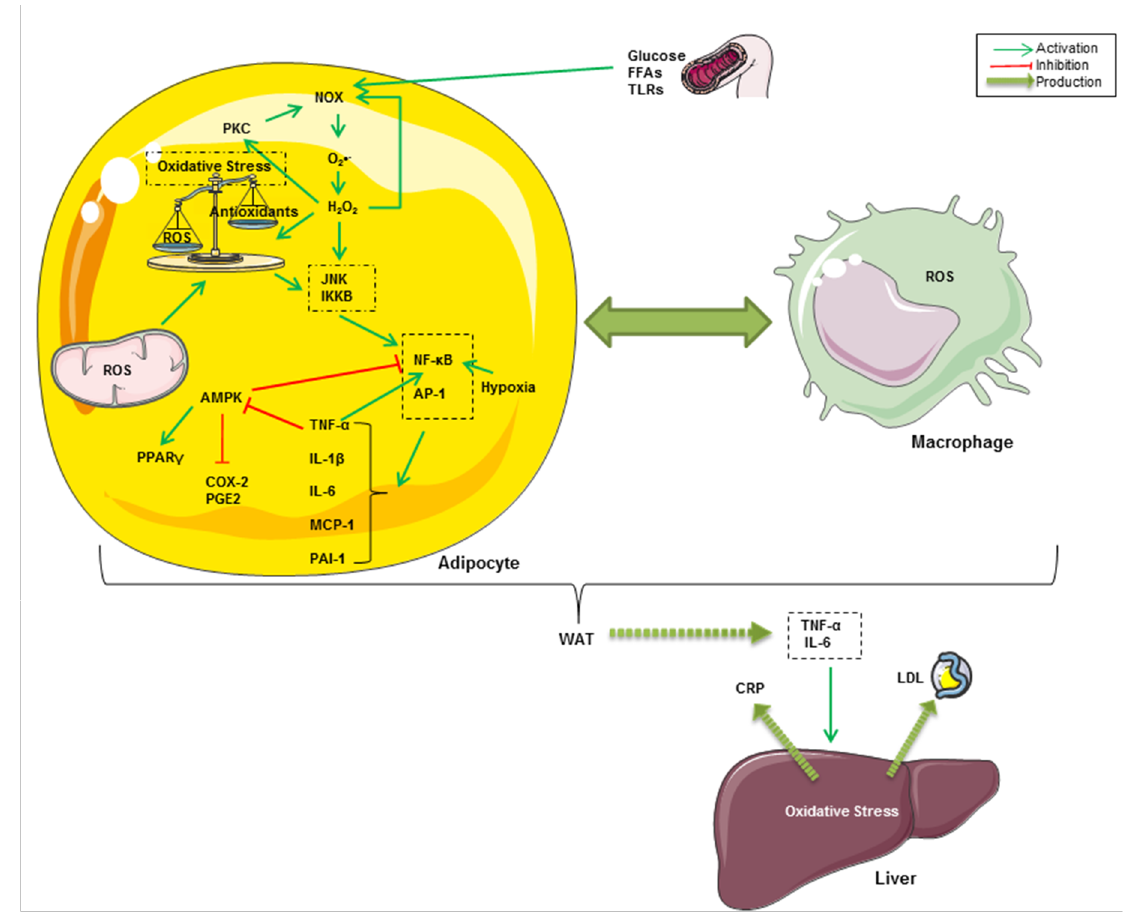
Figure 1. Graphical summary of some inflammatory and oxidative pathways related to obesity. High glucose intake and FFA-dependent TLR4 activation lead to the activation of NOX, which can also be activated by PKC in adipocytes. NOX mediates intracellular ROS generation, mainly O 2 •− , both in preadipocytes and macrophages. Likewise, mitochondrial ROS exacerbate oxidative stress and inflammatory processes in obesity. JNK mediates ROS and oxidative stress-dependent activation of NF- κ B and AP-1. These latters regulate gene expression of TNF- α , IL-6, MCP-1 and PAI-1. The NF- κ B pathway might be upregulated in hypoxic adipose tissue and in response to TNF- α . Furthermore, TNF- α inhibits AMPK pathways, resulting in increased COX-2 and PGE2 and decreased PPAR γ . TNF- α and IL-6 secreted from WAT enhance CRP and low-density lipoprotein (LDL) release from the liver in response to hepatic oxidative stress. A crosstalk between adipocytes and resident macrophages reinforces oxidative stress through TNF- α –mediated ROS generation within WAT cells in an autocrine and paracrine